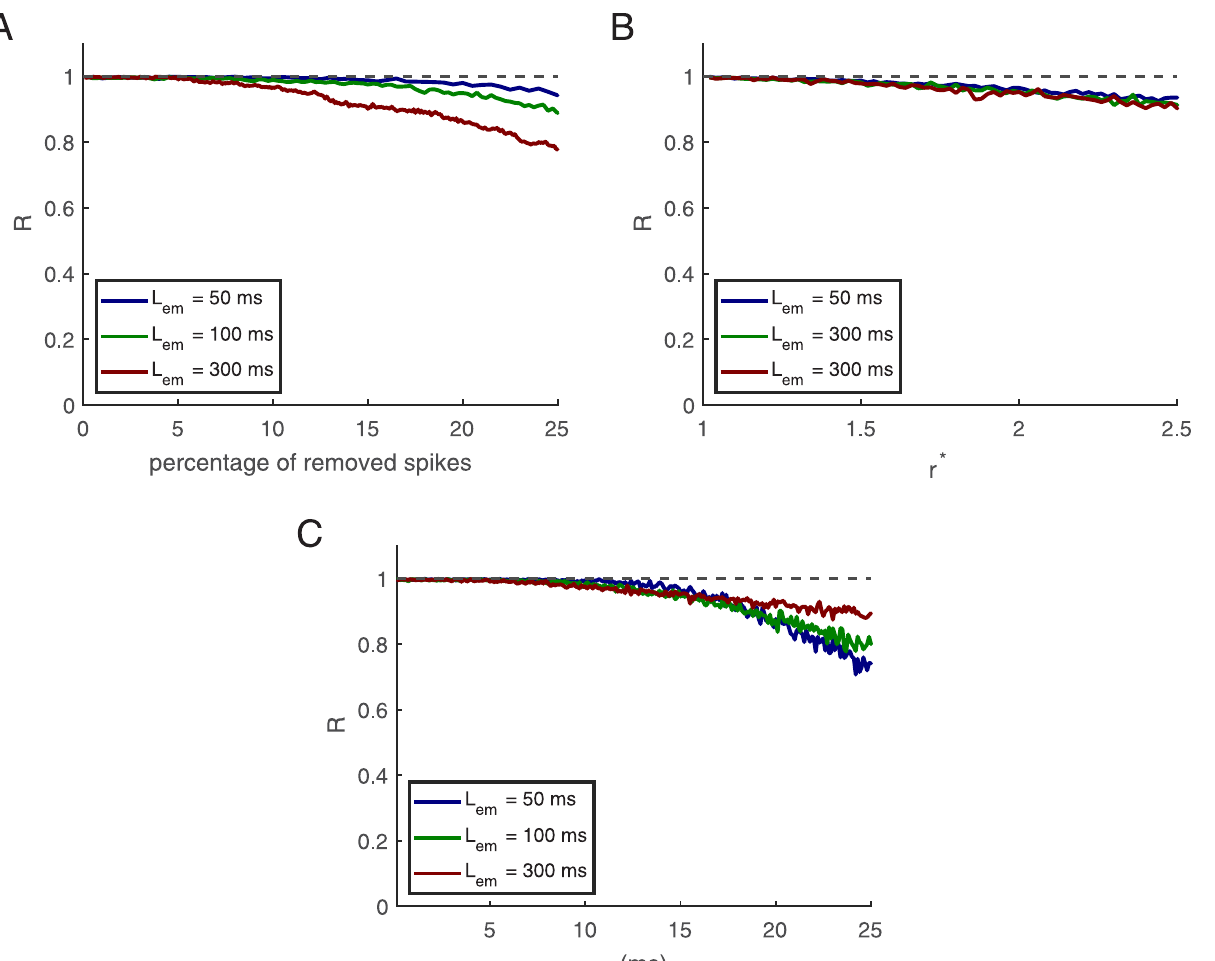
Fig 6. Testing noise robustness. (A) Removing spikes. (B) Increasing firing rates. (C) Jitter noise. Patterns durations are 50, 100, and 300 ms, shown in afferents starting from 500 milliseconds. This figure is based on an average of 500 simulations, in which there are 500 afferents, the length of the training epoch is 1000 ms, and r 0 = 2